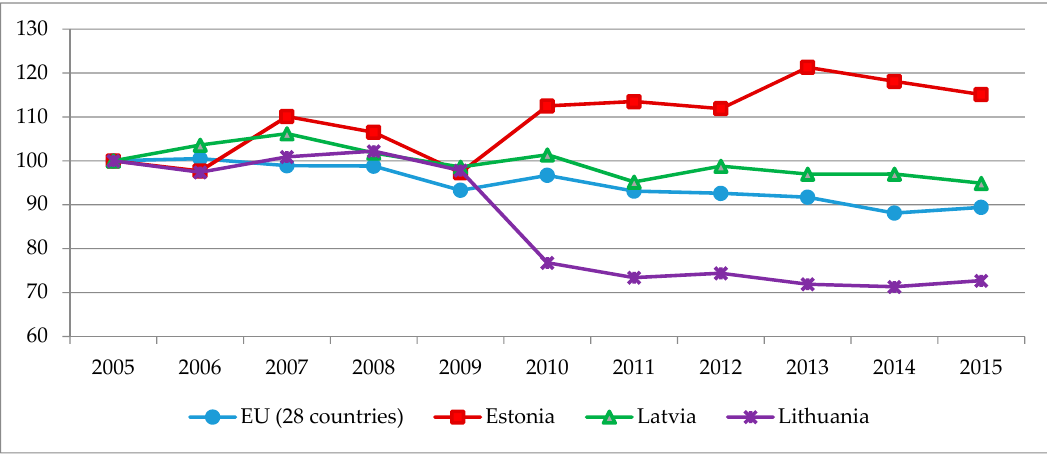
Figure 7. Primary energy consumption index, 2005 = 100.